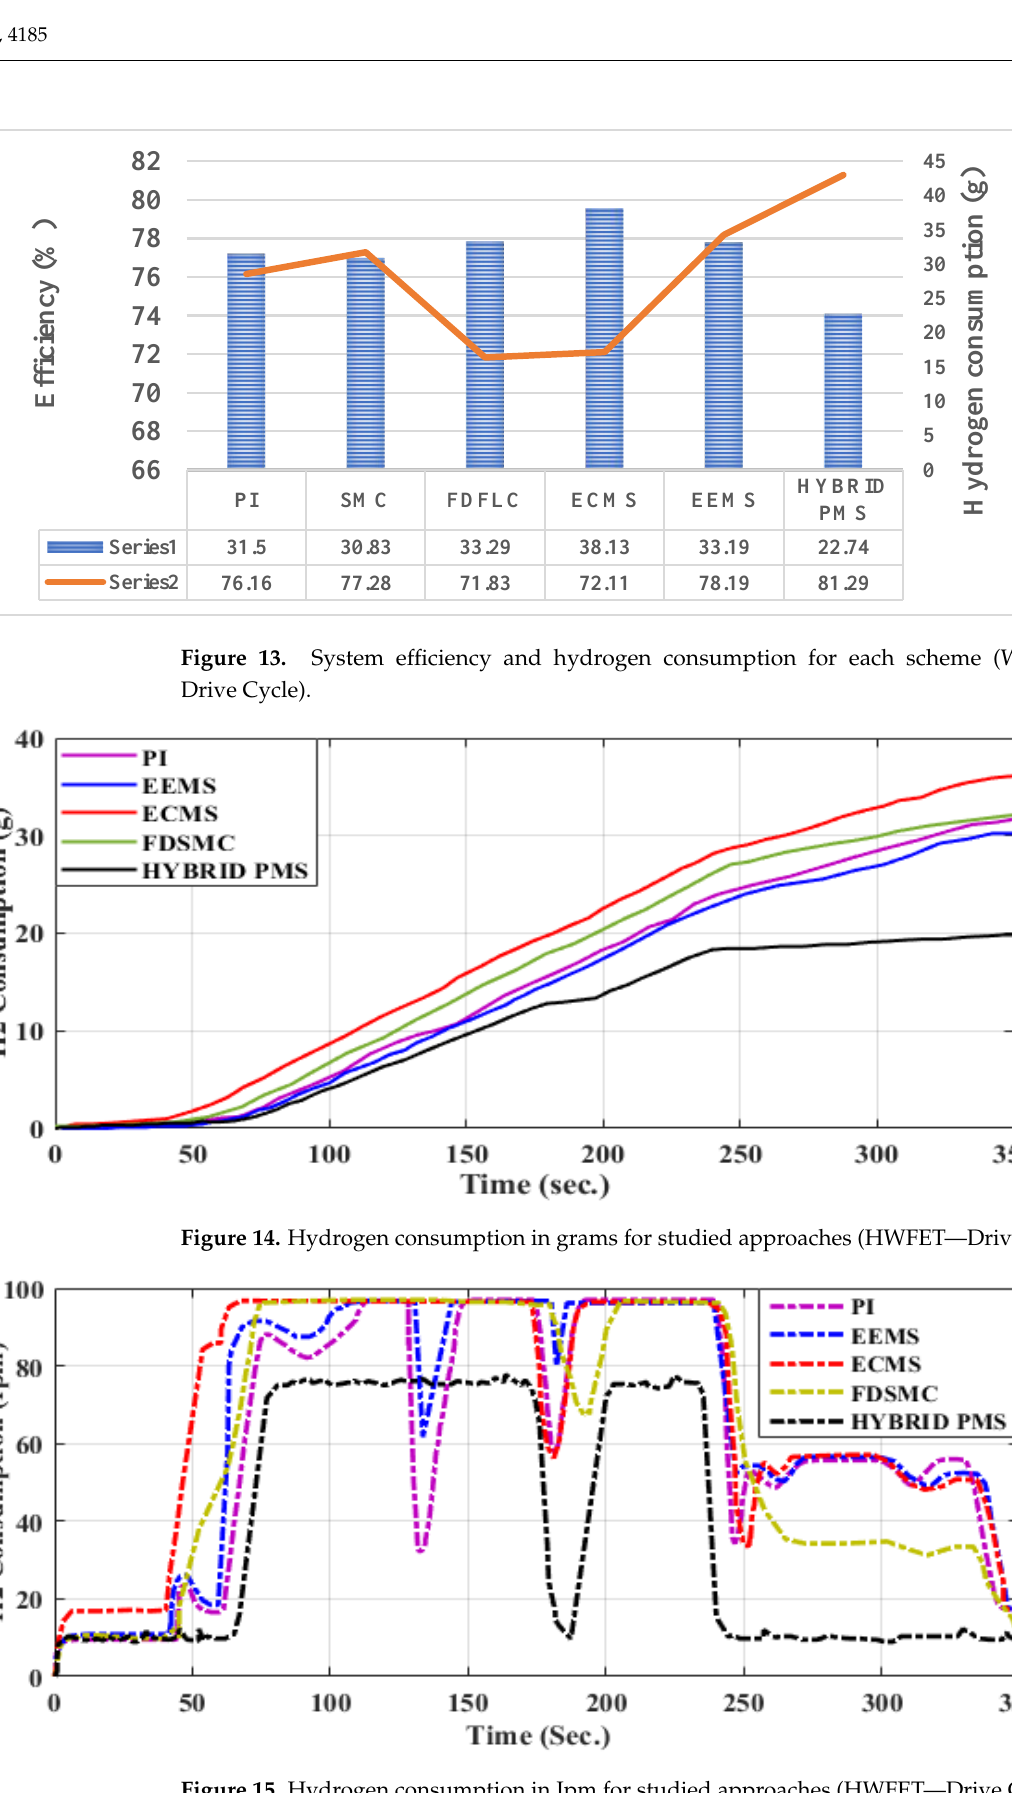
Figure 15. Hydrogen consumption in Ipm for studied approaches (HWFET — Drive Cycle).